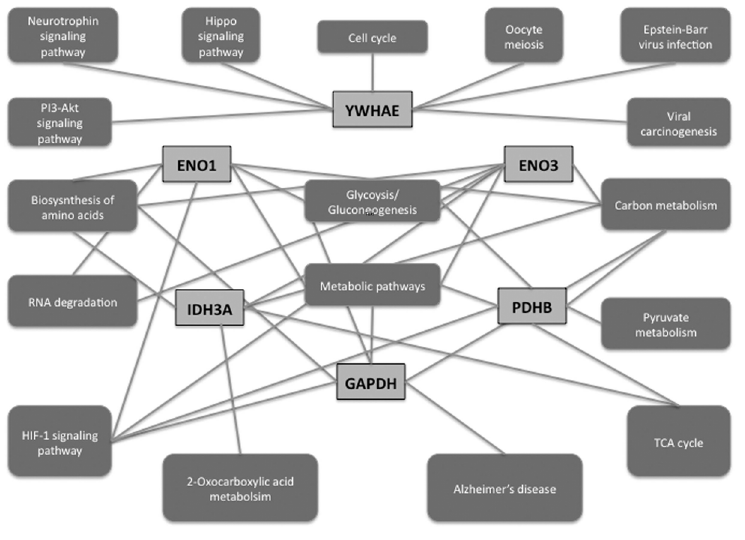
Fig 4. Protein association network showing interconnecting relationships between miR-153-3p and miR-205-5p target proteins through key regulatory pathways. YWHAE: 14-3-3 epsilon protein; ENO1: Alpha-enolase; ENO3: beta-enolase; IDH3A: Isocitrate dehydrogenase [NAD] subunit alpha; PDHB: Pyruvate dehydrogenase complex beta subunit; GAPDH: Glyceraldehyde-3-phosphate dehydrogenase.